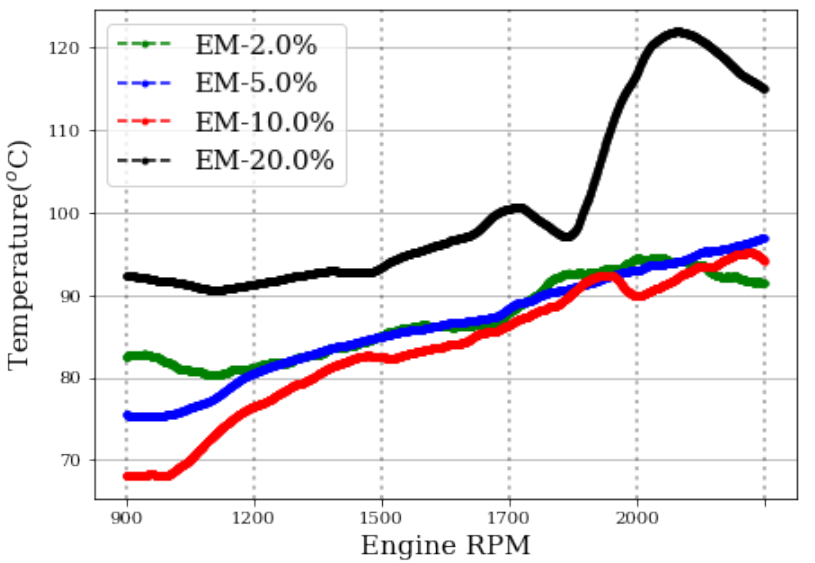
Figure 4. Exhaust temperature for different emulsion compositions at increasing engine